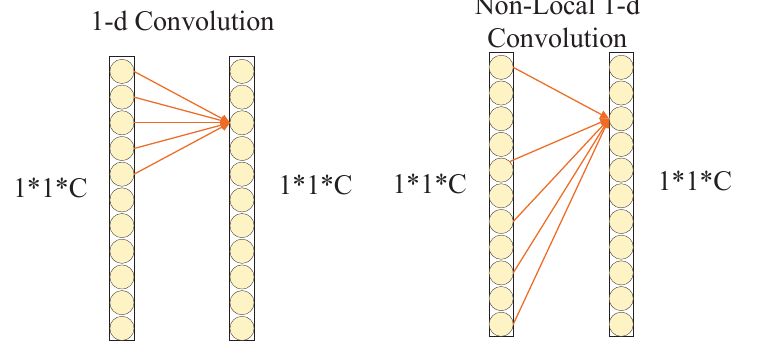
Figure 5. Conv1d and Non-Local